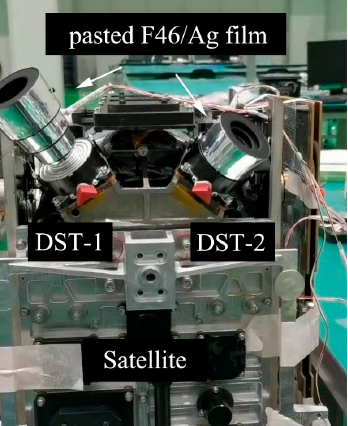
Figure 14. Two deployable star trackers with slivered fluorinated ethylene propylene F46/Ag film